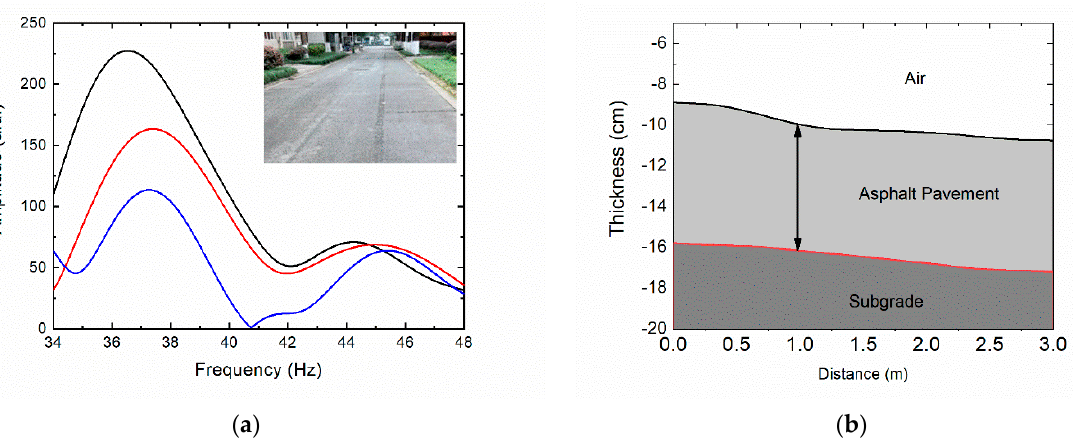
Figure 6. ( a ) Three spectrogram datasets calculated by CZT ( b ) Two-dimensional imaging of asphalt pavement.